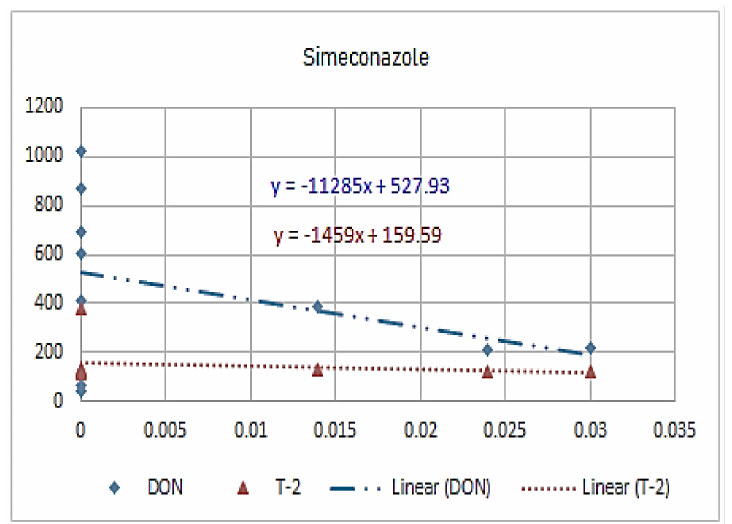
Figure 1. The relation between simeconzole residue (ppb) and DON and T-2 toxin (ppb) in wheat samples.